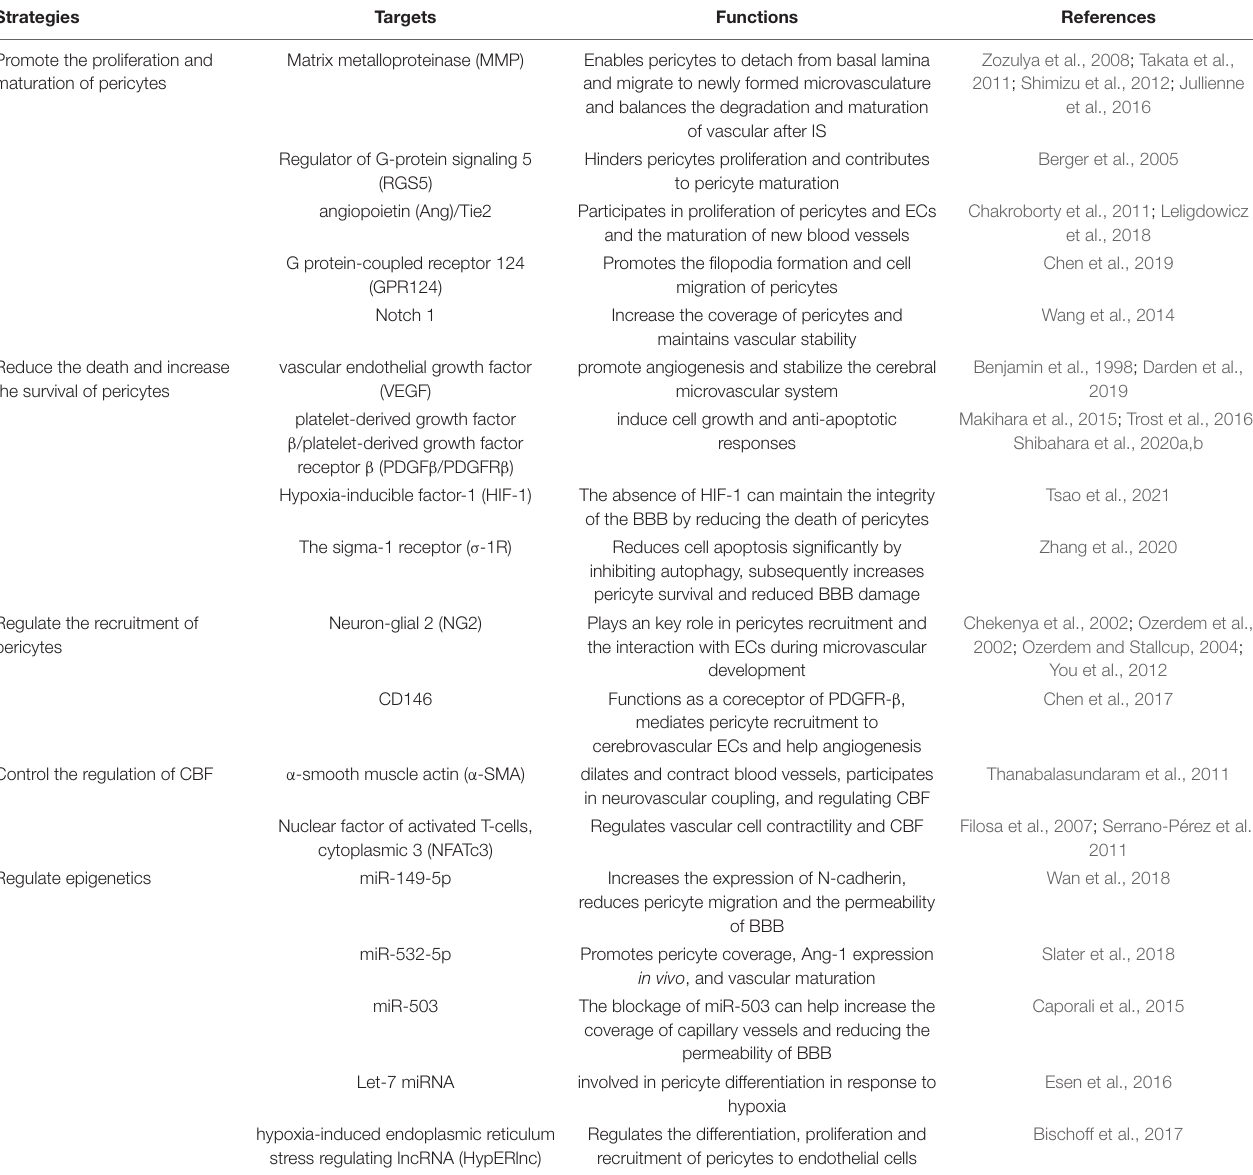
TABLE 1 | Potential targets of treating IS that target